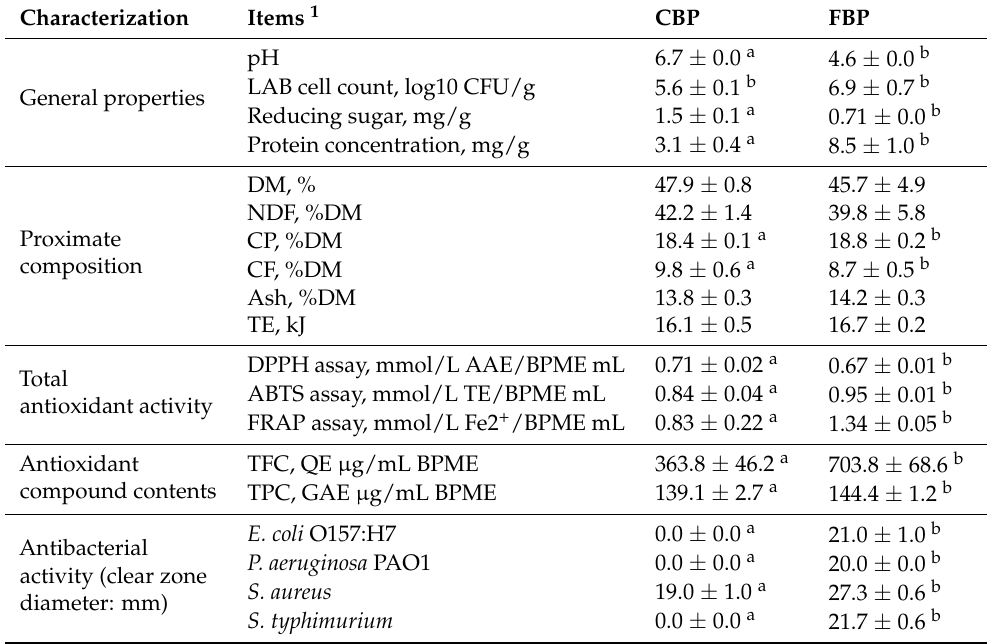
Table 1. Characterization of the raw (CBP) and the Lp-fermented B. papyrifera product (FBP) under practical